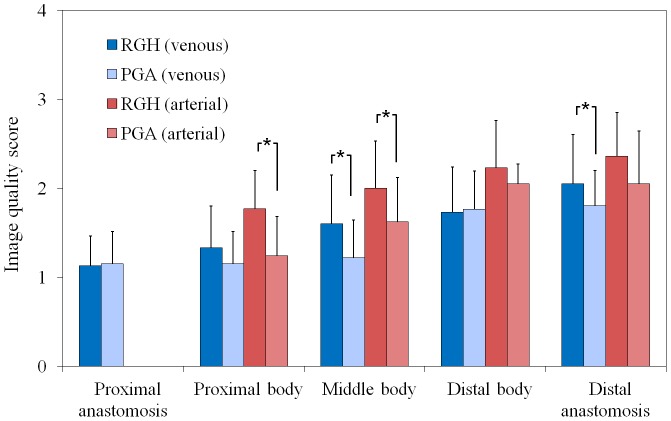
Bar chart demonstrated mean image quality scores of arterial and venous grafts for each segment in RGH and PGA techniques.(*: p<0.05).